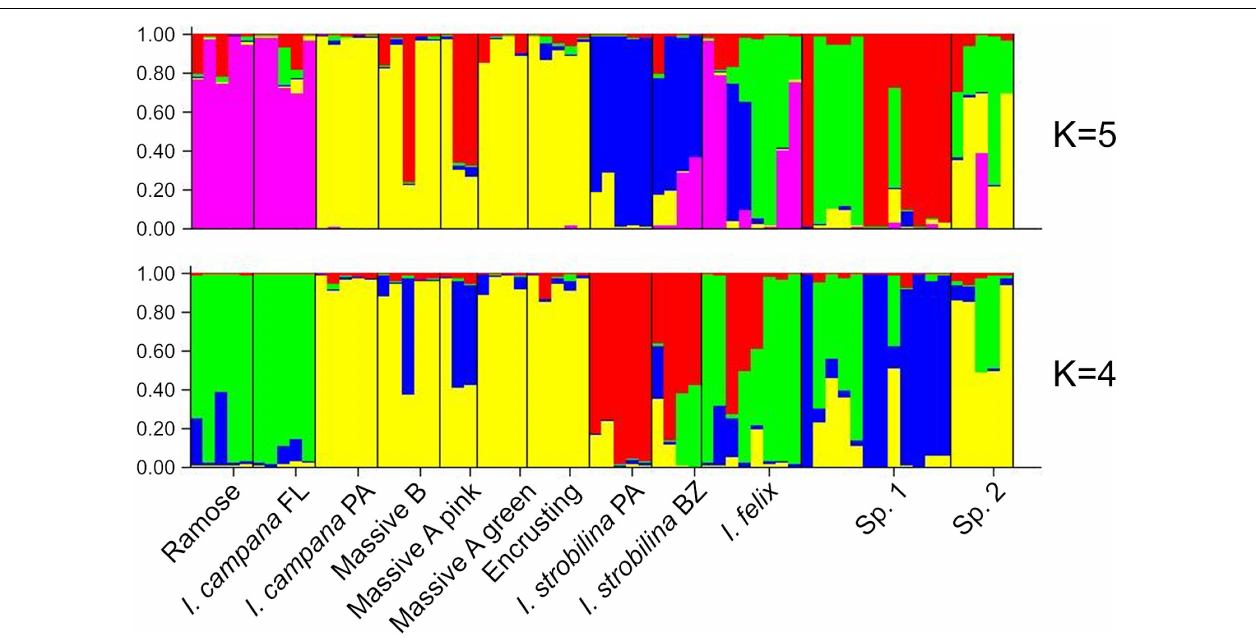
FIGURE 5 | Structure plots of ancestries of neutrally evolving SNPs estimated for K = 4 and K =